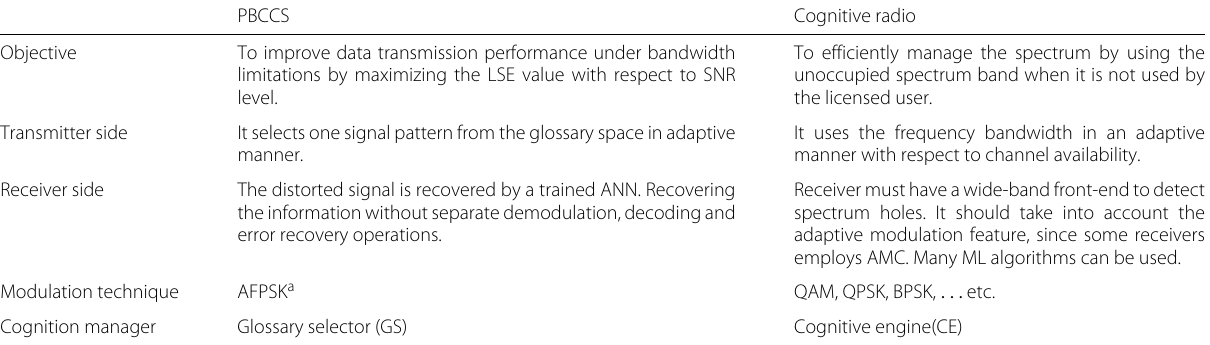
Table 1 Comparison between pattern based cognitive communication system and cognitive radio PBCCS Cognitive radio